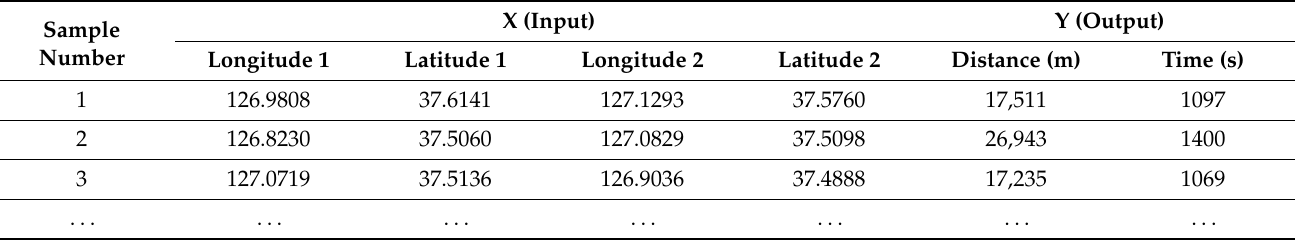
Table 1. Examples of the collected samples for input and output